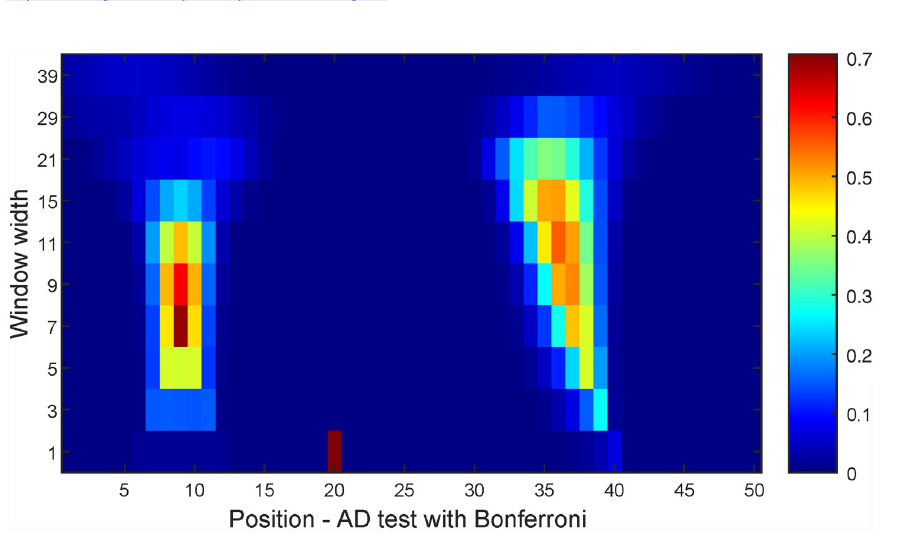
Fig 6. Rejection ratios of all resolution/position pairs for 1 000 replications of the motivational example.